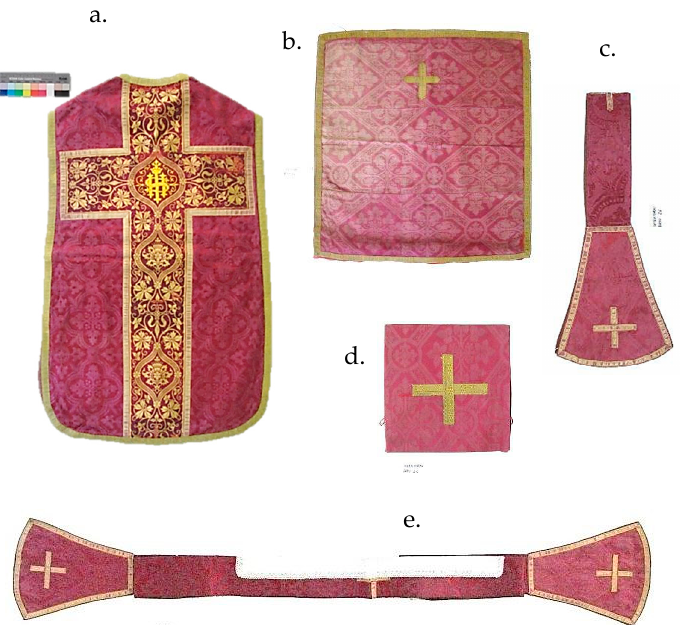
Figure 1. Set of liturgical vestments: ( a ) chasuble, ( b ) velum, ( c ) maniple, ( d ) burse and ( e ) stole.